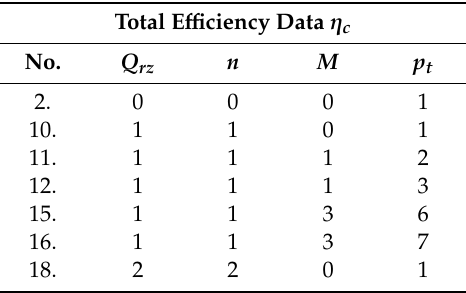
Table 4. Logically coded data for η c